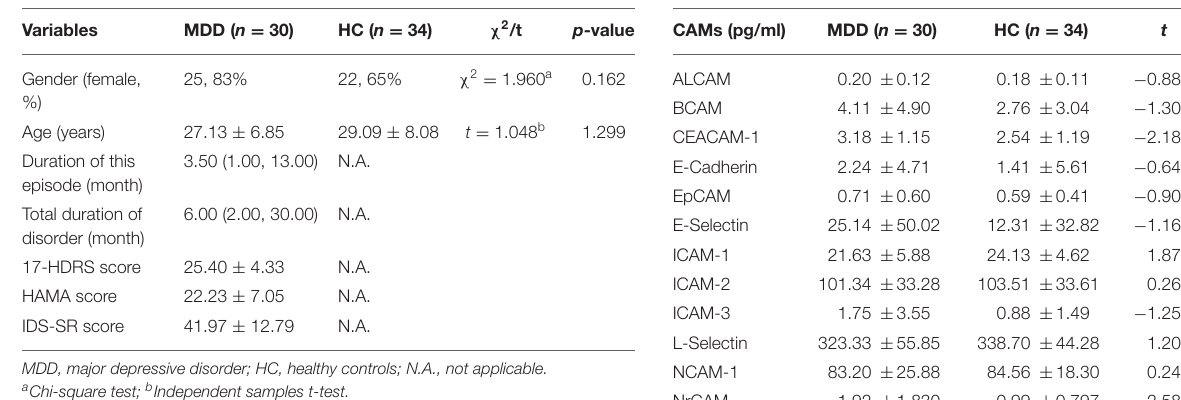
TABLE 1 | Demographic and clinical characteristics of MDD and HC subjects. TABLE 2 | The levels of CAMs in plasma from MDD patients compared to